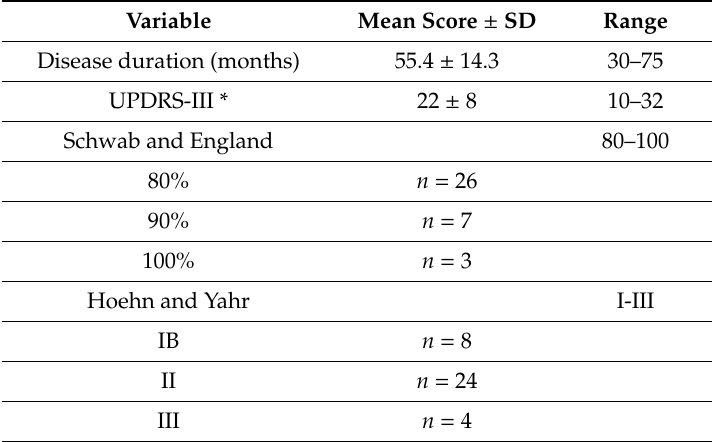
Table 1. Clinical features of the sample with Parkinson’s